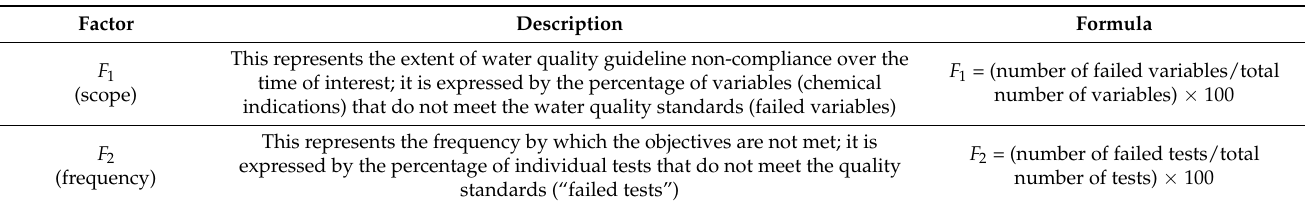
Table 1. Detection parameters for RTWQI calculation